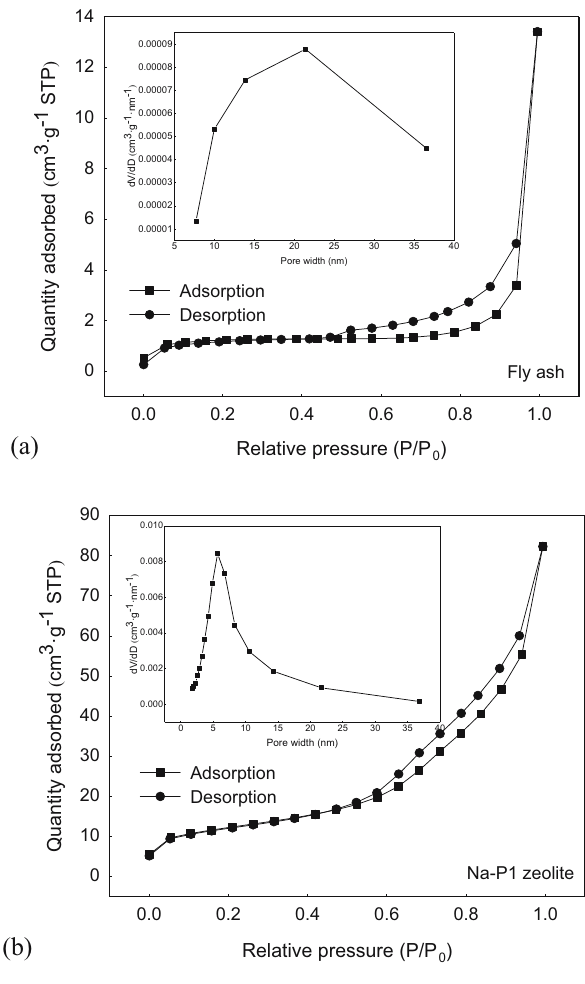
Figure 3: Adsorption – desorption isotherms and pore size distribu - tion of ( a ) fl y ash and ( b ) Na - P1 zeolite.